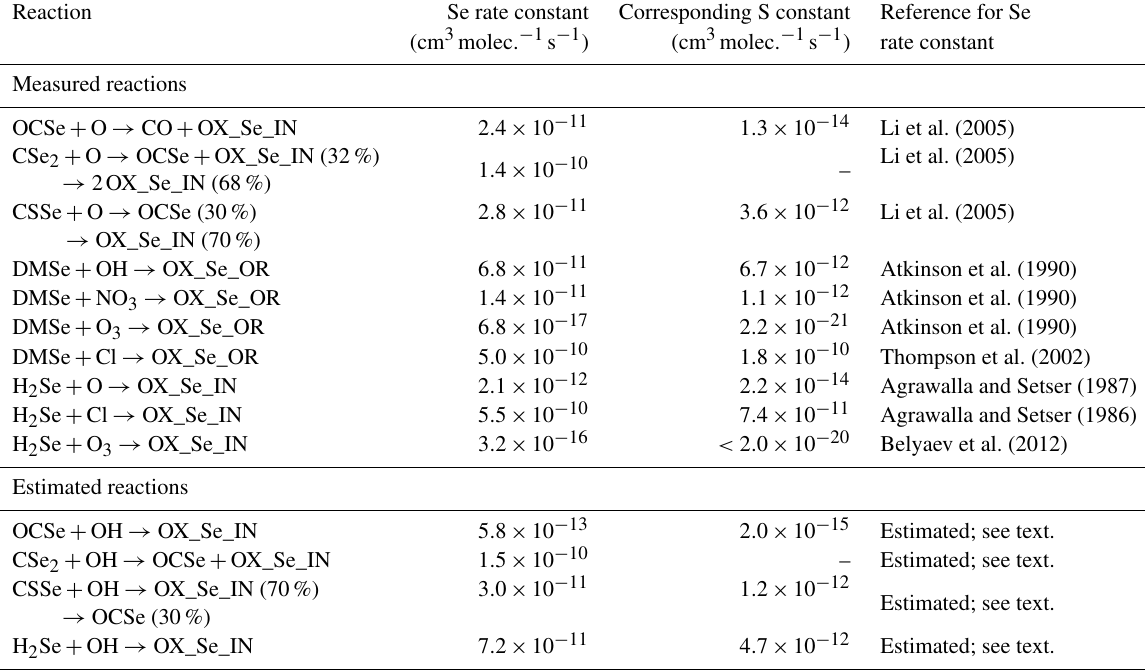
Table 2. Rate constants of Se compound gas-phase reactions at around 298 K and the corresponding rate constant of the analogous S compound. All S reaction rates are from Burkholder et al. (2015), except the DMS + O 3 reaction rate which is taken from Wang et al. (2007). No corresponding rate constants for CSe 2 reactions are listed, since CSe 2 is obtained from doubly substituting Se in CS 2 . Reaction Se rate